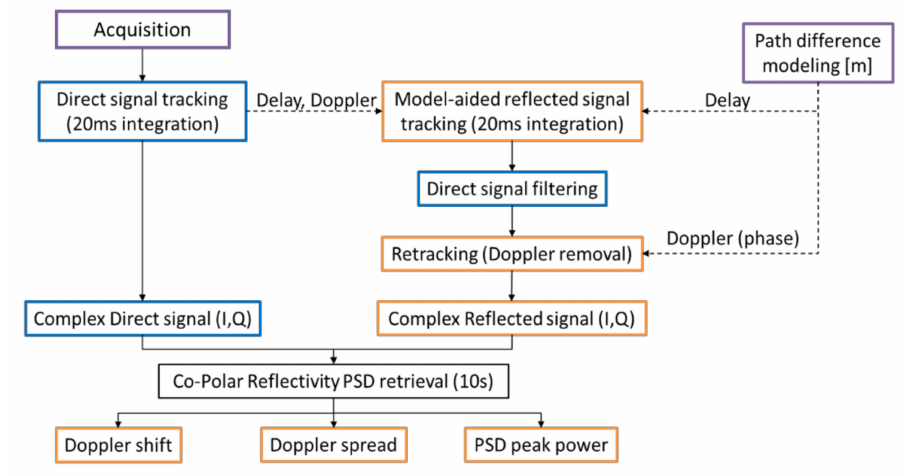
Figure 4. Signal processing